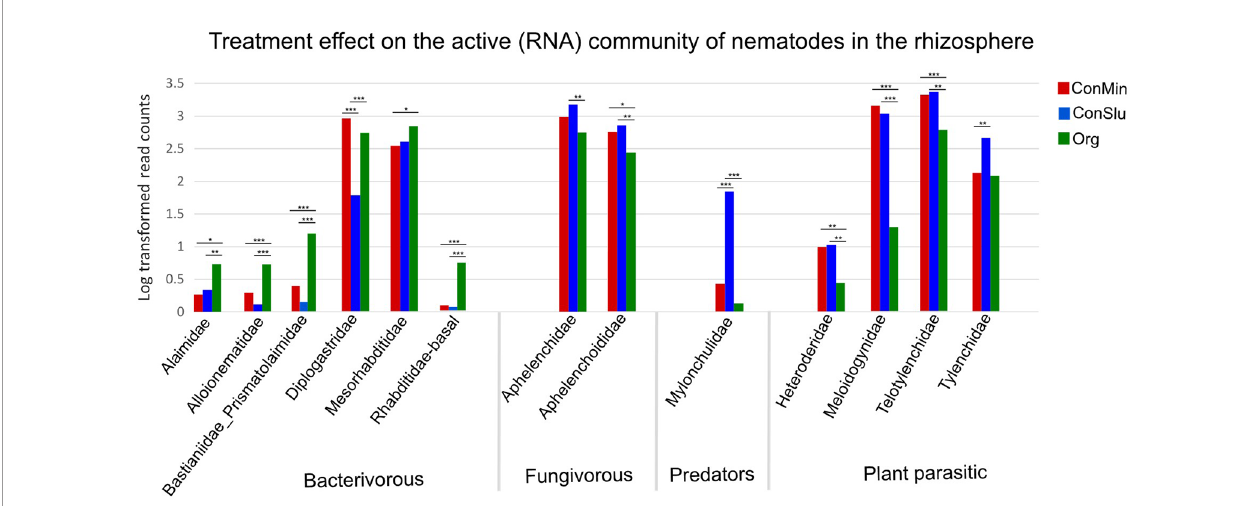
FIGURE 5 | Shifts in the active nematode communities in the rhizosphere for each of the three soil management regimes: ConMin (red), ConSlu (blue) and Org (green). Each bar represents the average of 36 data points (18 subplots were sampled at two time points). Kruskal-Wallis test, followed by Dunn ’ s Test. (* = p < 0.05, ** = p <0.01, *** = p